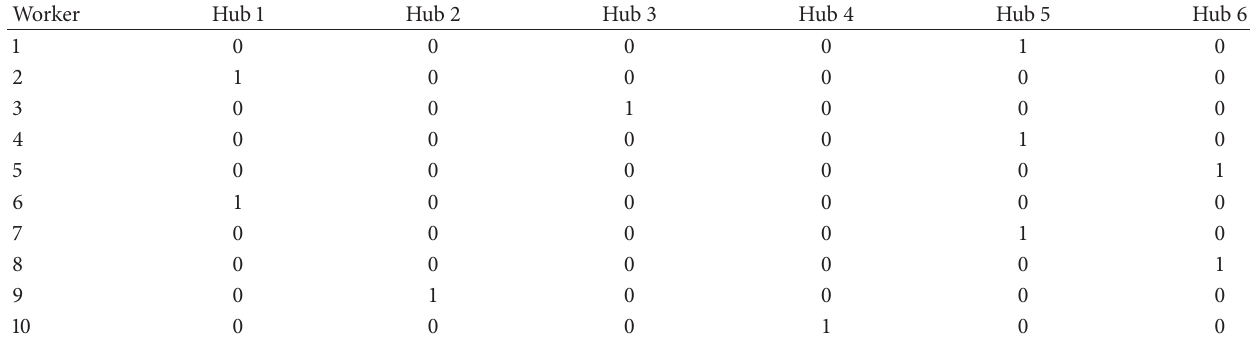
Table 6: The worker-to-hub assignment plan.